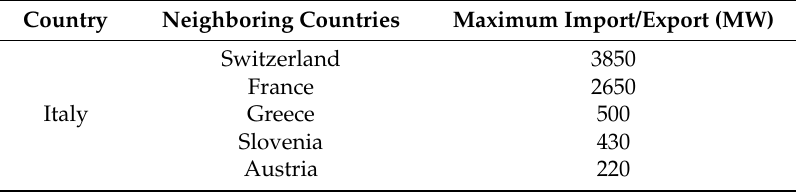
Table 3. Maximum import/export capacity between Italy and the neighboring countries.